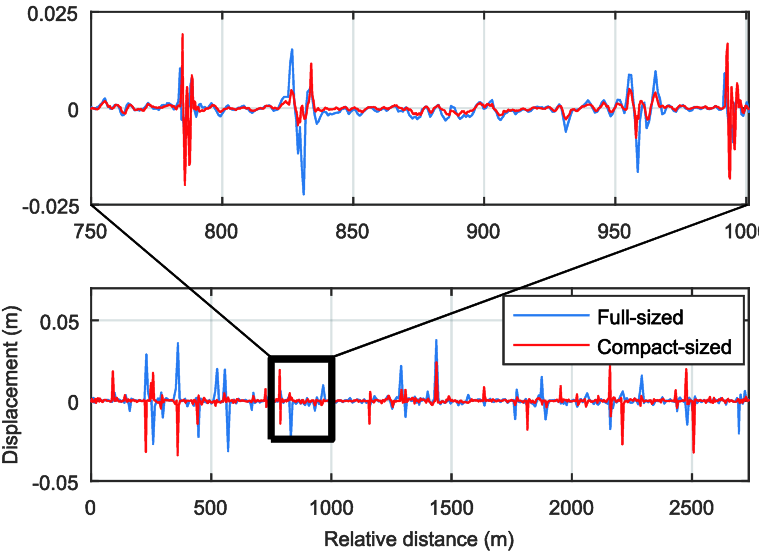
Figure 14. Estimated longitudinal road profile.